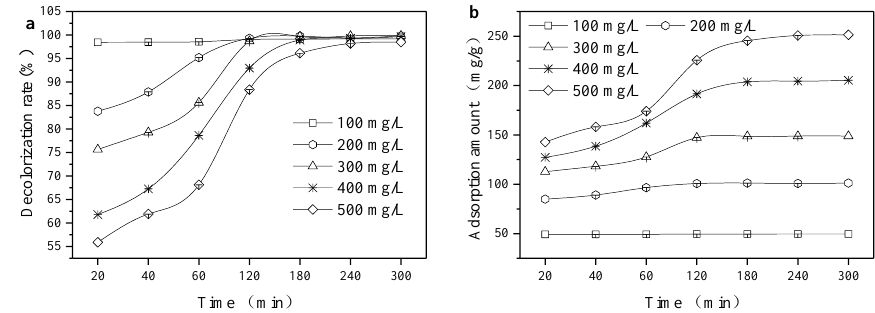
Figure 7. Effect of initial dye concentration on the decolorization rate ( a ) and adsorption amount ( b ). The adsorption test was conducted with 2 g/L of modified sepiolite under an oscillation rate of 170 r/min and a temperature 25 °C.